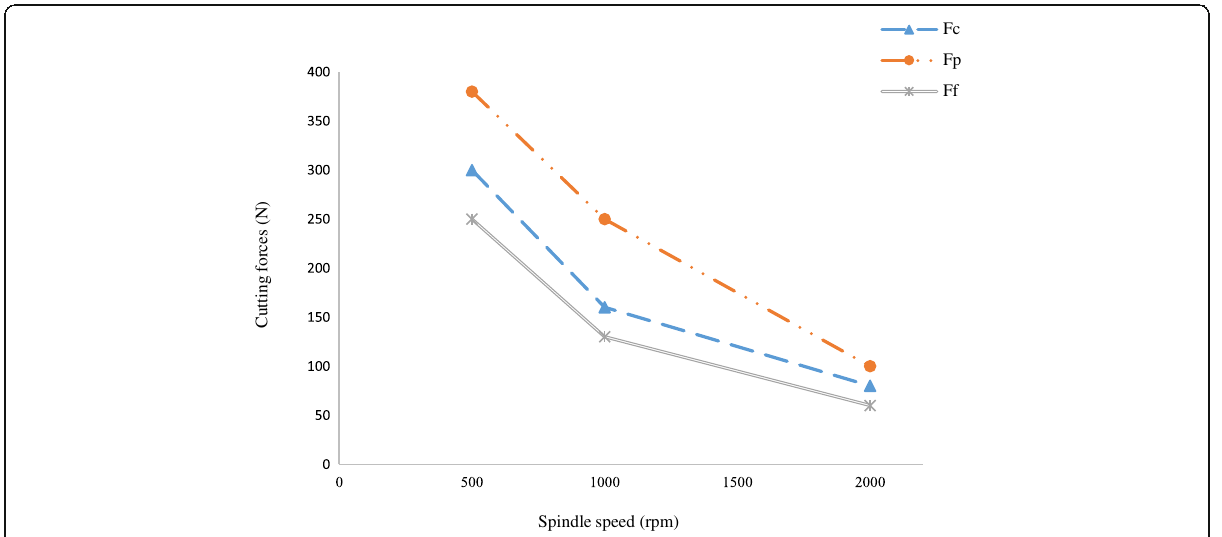
Fig. 4 The effect of the spindle speed on the cutting forces at 0.16 mm/rev feed rate, 0.5 mm cutting depth, and 0.8 mm nose